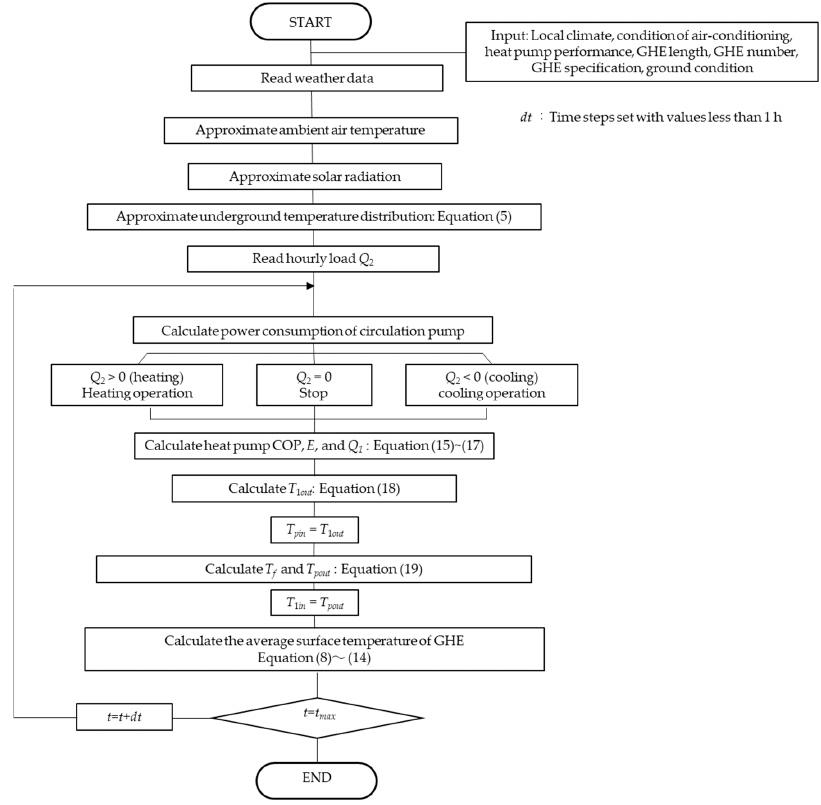
Figure 2. Performance prediction tool calculation flow considering influence of ground surface.